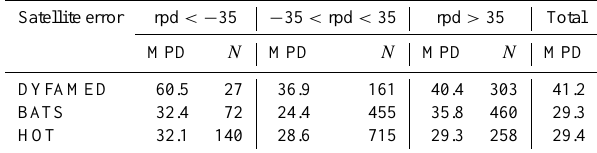
Fig. 3. Scatter plot of integrated Chl a content over 200m com- puted on “satellite-corrected” profiles, as a function of integrated Chl a content computed on “HPLC-calibrated” profiles. Both Chl a contents are expressed in mgm − 2 . Similarly to Fig. 1, colour code refers to the error of satellite in the estimation of near-surface Chl a C . Table 4. Impact of the satellite Chl a C accuracy on the error of final corrected profiles. The satellite error was measured with the relative percent difference (rpd) between satellite extracted Chl a C and near surface Chl a C derived from HPLC profiles. The accu- racy of the merging method was assessed with the median absolute percent difference (MPD) between “satellite-corrected” and HPLC data